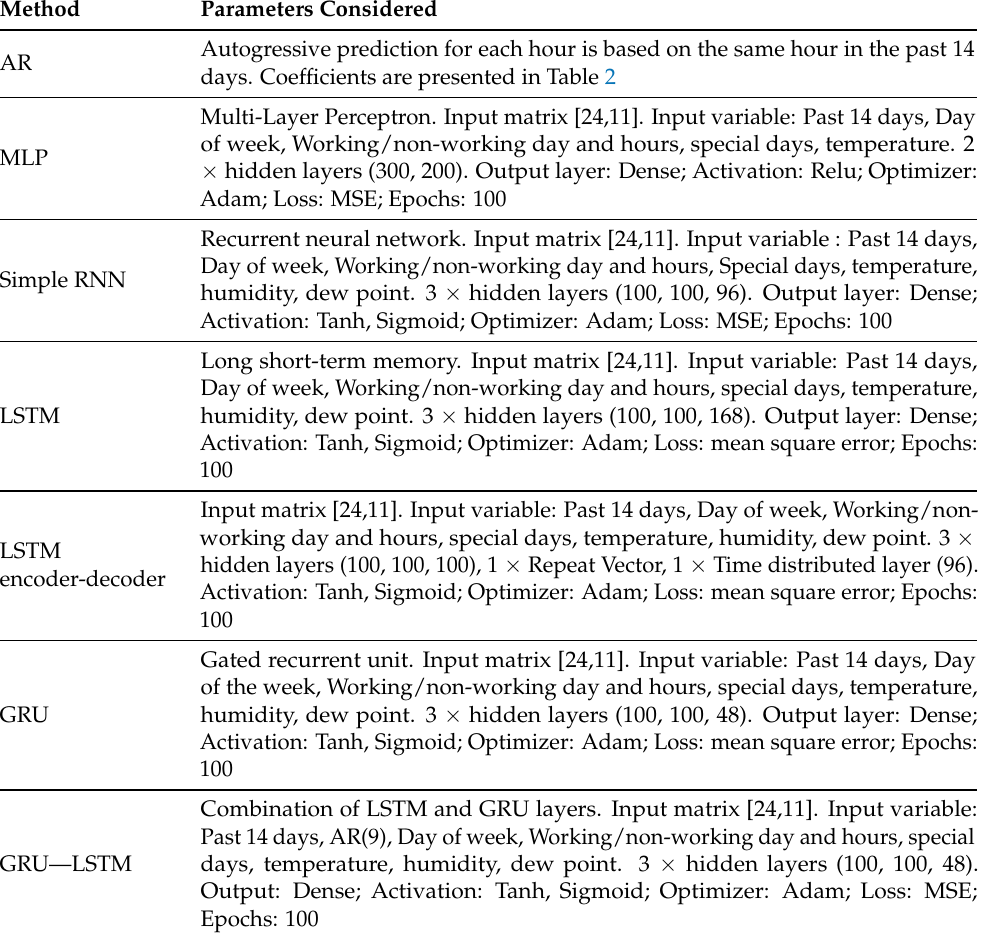
Table 4. Parameters used by the forecast methods implemented in this work.